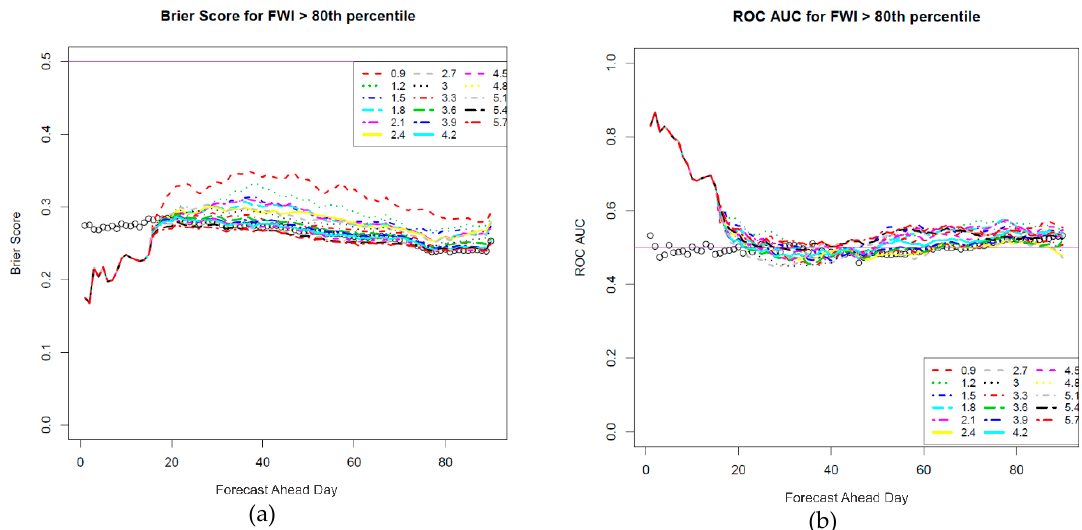
Figure 10. ( a ) Brier Score; ( b ) relative operating characteristic (ROC) area under the curve (AUC) vs. the number of days ahead that the forecast was made (1–90). This is shown for various Score Sums (listed in the legend), which control the number of historical analogue years to append to day 15. The black circles are the measures for climatology. Our forecast’s ( a ) Brier Score should be below climatology’s to show “skill” when compared to climatology. Our forecast’s ( b ) ROC AUC should be above climatology’s to show “skill” and should exceed 0.6 (or at least be above 0.5 to suggest any skill compared to randomly guessing).